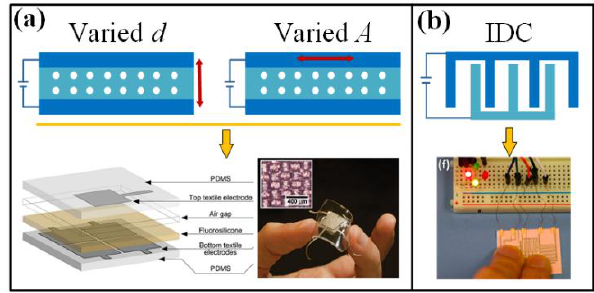
Figure 7. Available working concepts for capacitive wearable sensors, including varying d , A and IDC. Reproduced from [126] with permission of WILEY. Adapted with permission from [131], Copyright (2014) American Chemical Society.